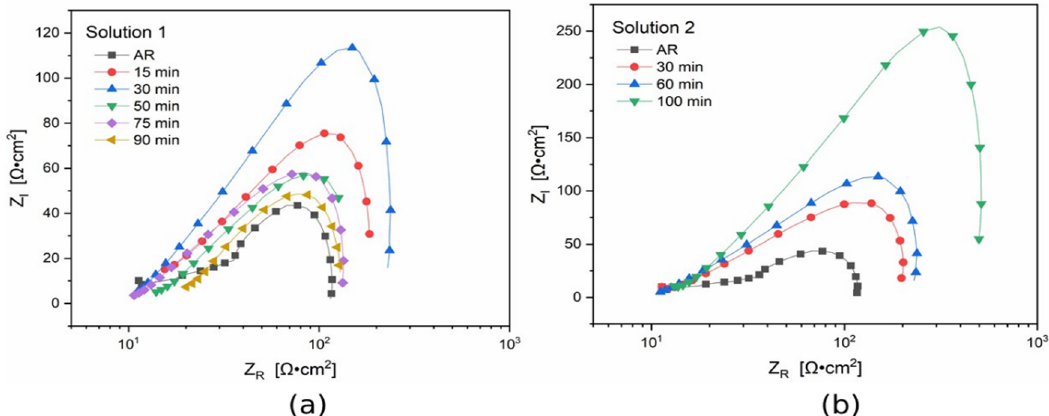
Figure 12. Nyquist plots of electrochemical impedance spectroscopy (EIS) measurements performed for the samples treated in solution 1 at 50 °C ( a ) and for the samples treated in solution 2 at ambient temperature ( b ). Test electrolyte: commercial solution that simulates cleaning product. Dots represent experimental data and lines show the result of the fitting.